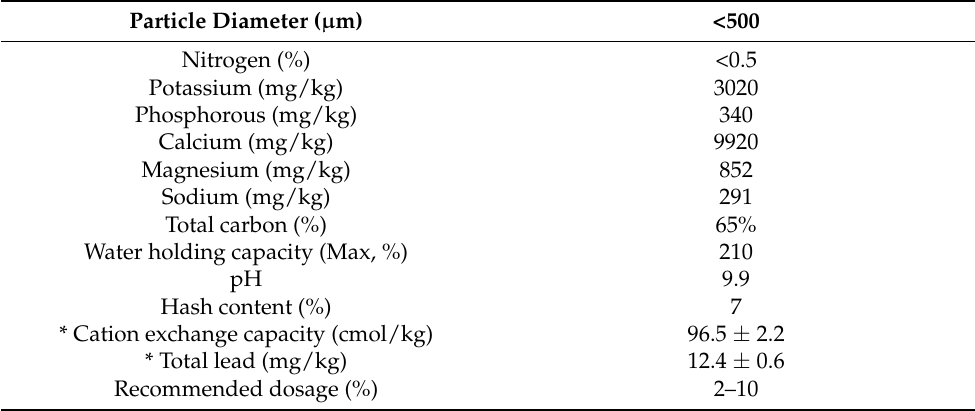
Table 1. Characteristics of the biochar used in this study [20]. * = measured in this